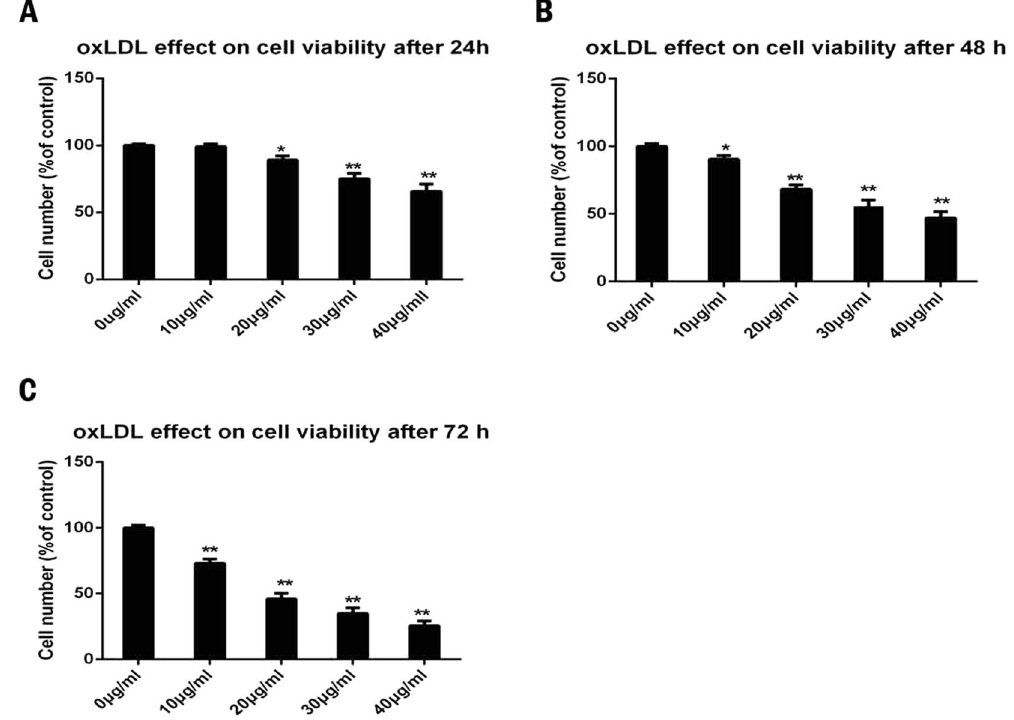
Figure 3. OxLDL induced apoptotic cell death in nucleus pulposus with CCK8 assay. ( A , B , C ) Effect of increasing concentrations of ox-LDL (0–40 μ g/ml) on nucleus pulposus cells viability after 24 h ( A ), 48 h ( B ) and 72 h ( C ). The cells without ox-LDL treatment were served as control. The cell number were decreased into 99.1% for 10 μ g/ml, 89.1% for 20 μ g/ml, 75.12% for 30 μ g/ml, 65.6% for 40 μ g/ml after incubating with oxLDL for 24 h. The cell number were decreased into 90.39% for 10 μ g/ml, 68.17% for 20 μ g/ml, 55.28% for 30 μ g/ml, 47.12% for 40 μ g/ml after incubating with oxLDL for 48 h and into 73.1% for 10 μ g/ml, 46.1% for 20 μ g/ml, 35.12% for 30 μ g/ml, 25.6% for 40 μ g/ml after incubating with oxLDL for 72 h. Cell numbers are expressed as a percentage of the controls. Data are shown as the mean ± SD of three independent experiments. A one-way ANOVA were used for statistical assessments. ( * P < 0.05, ** P <